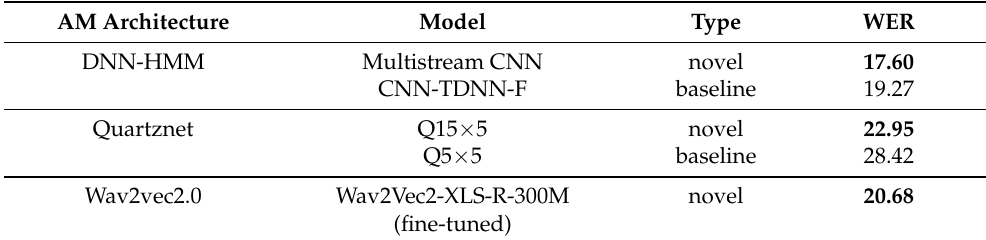
Table 4. Total WER results per system on the whole Albayzin-RTVE 2020 testset. The results of the novel and evolved ASR engines are marked in